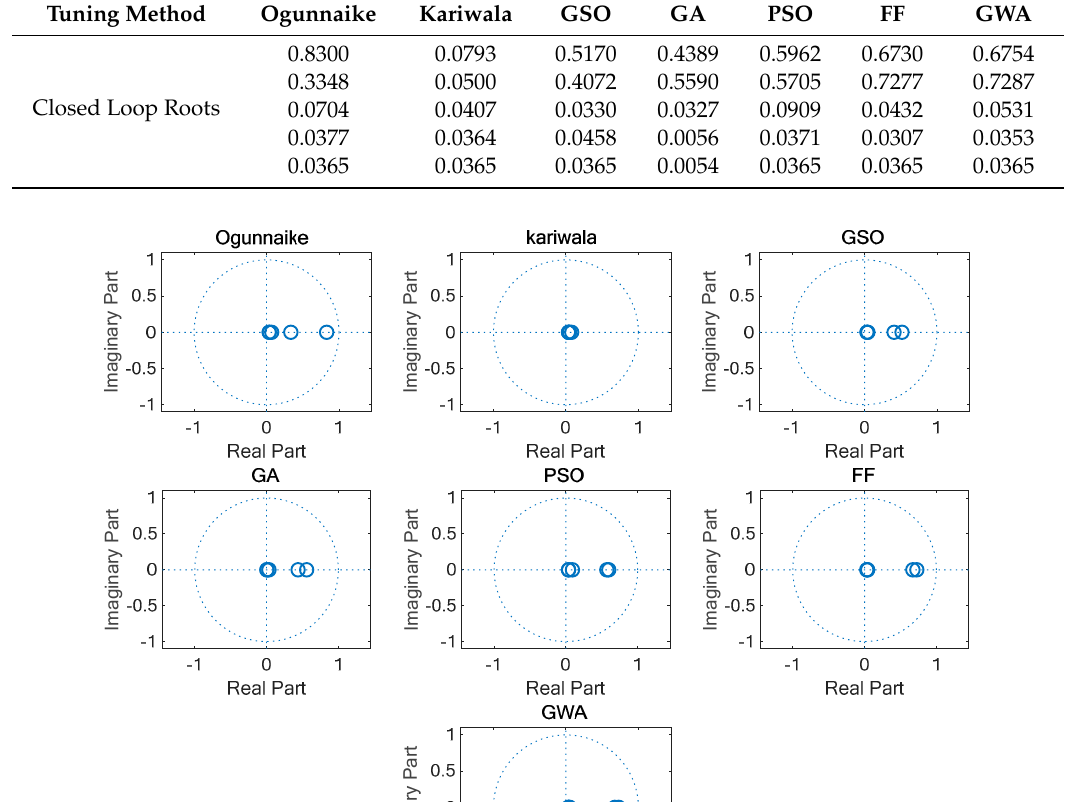
Figure 18. Response to Tool III for changing the θ A parameter.